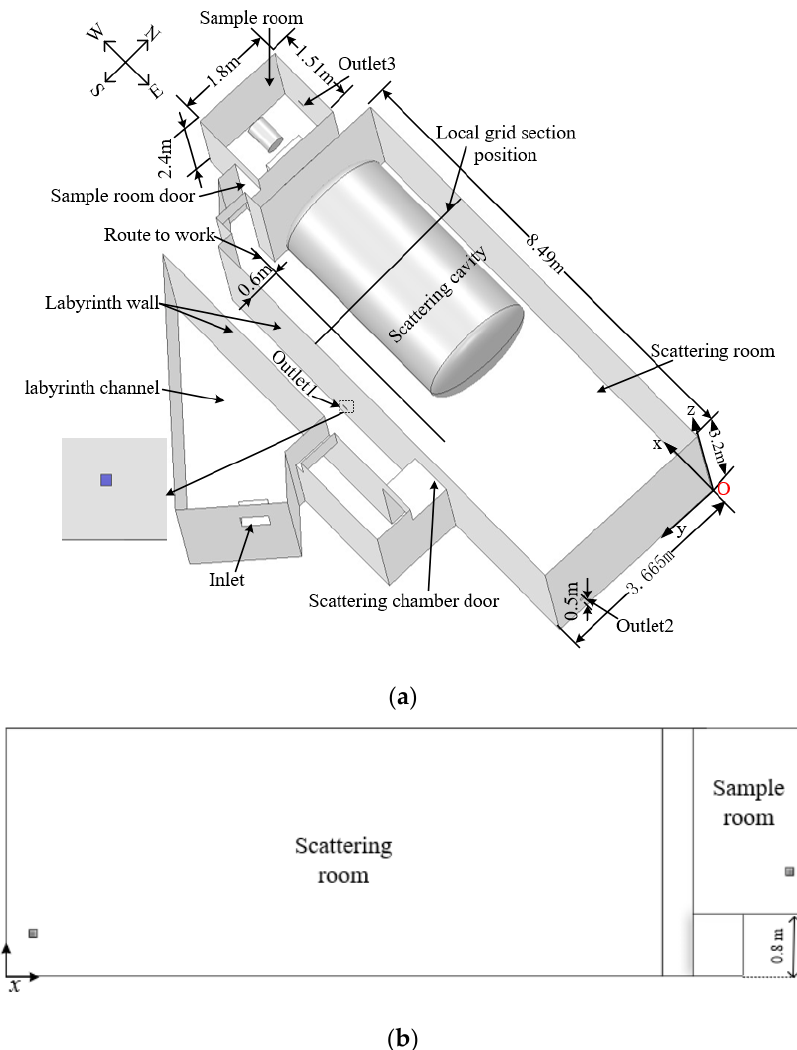
Figure 1. The calculation domain model. ( a ) Three-dimensional structure diagram of scattering room and sample room. ( b ) The side view of scattering and sample room.